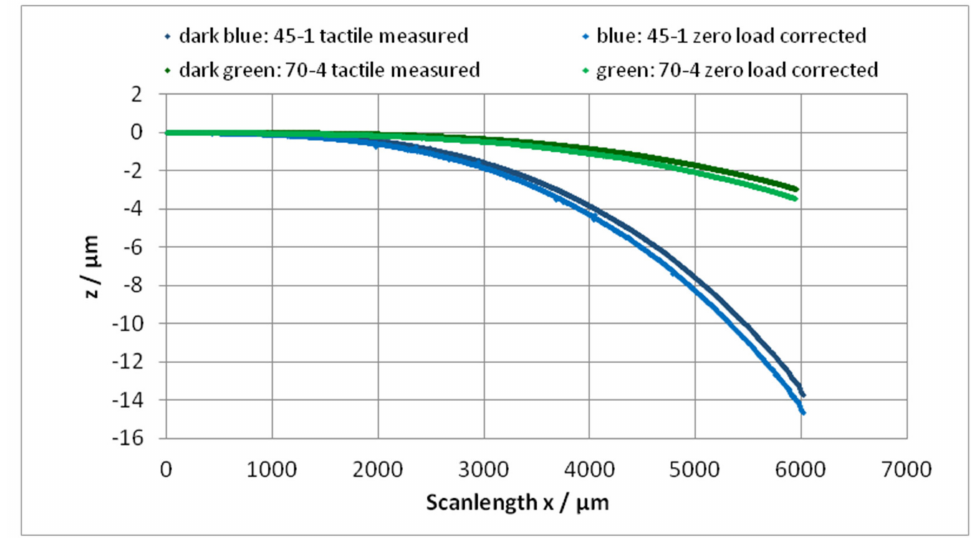
Figure 10. The bending lines of the cantilevers 45-1 and 70-4 before and after zero-load correction. A plot of all ( z − z 0 ) values against x 3 should generate a linear function. From the trendline (linear regression), a slope of ( z − z 0 )/x 3 results, as shown in Figure 11.